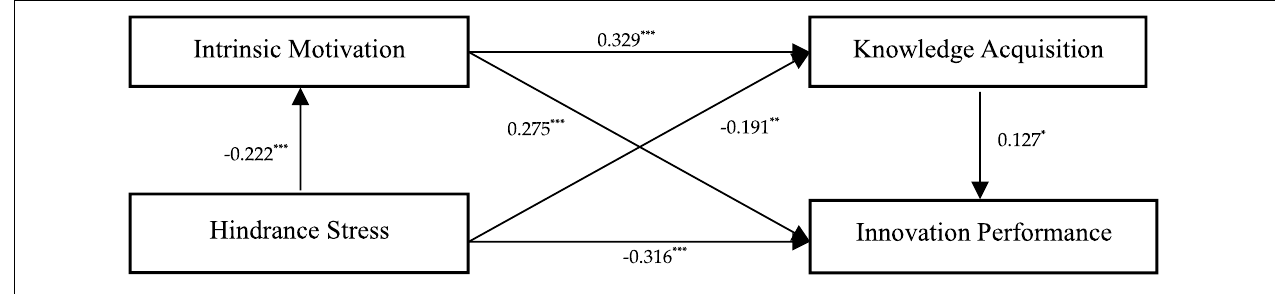
FIGURE 3 | Main effect and indirect effect. n = 376; * p < 0.05; ** p < 0.01; *** p <